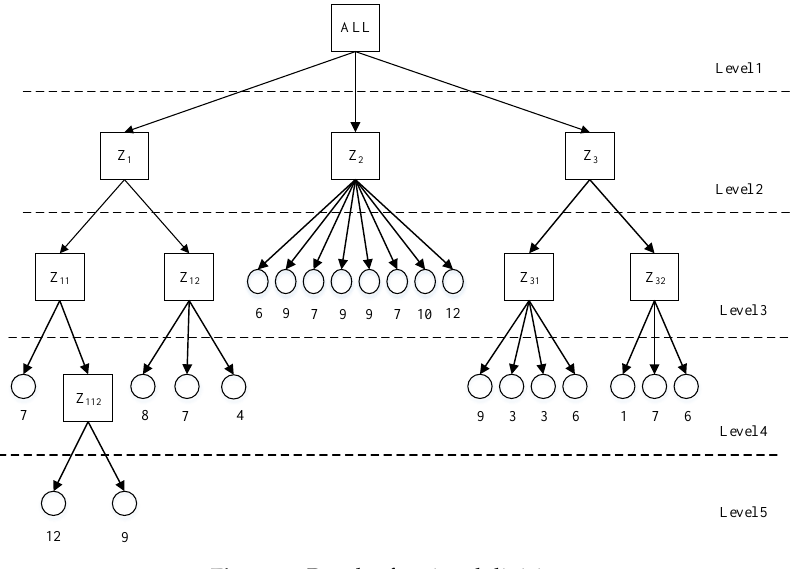
Figure 6. Result of regional division.